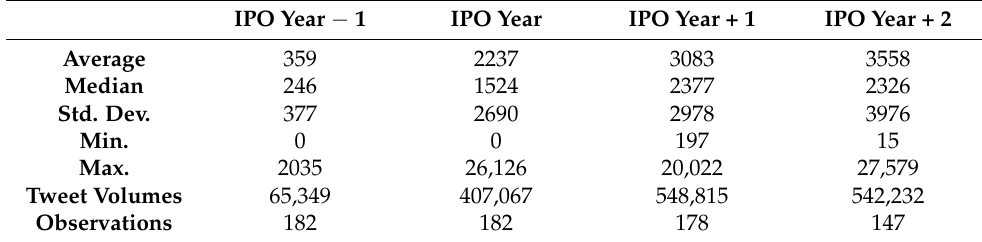
Table 4. Annual Volume of Tweets: Descriptive